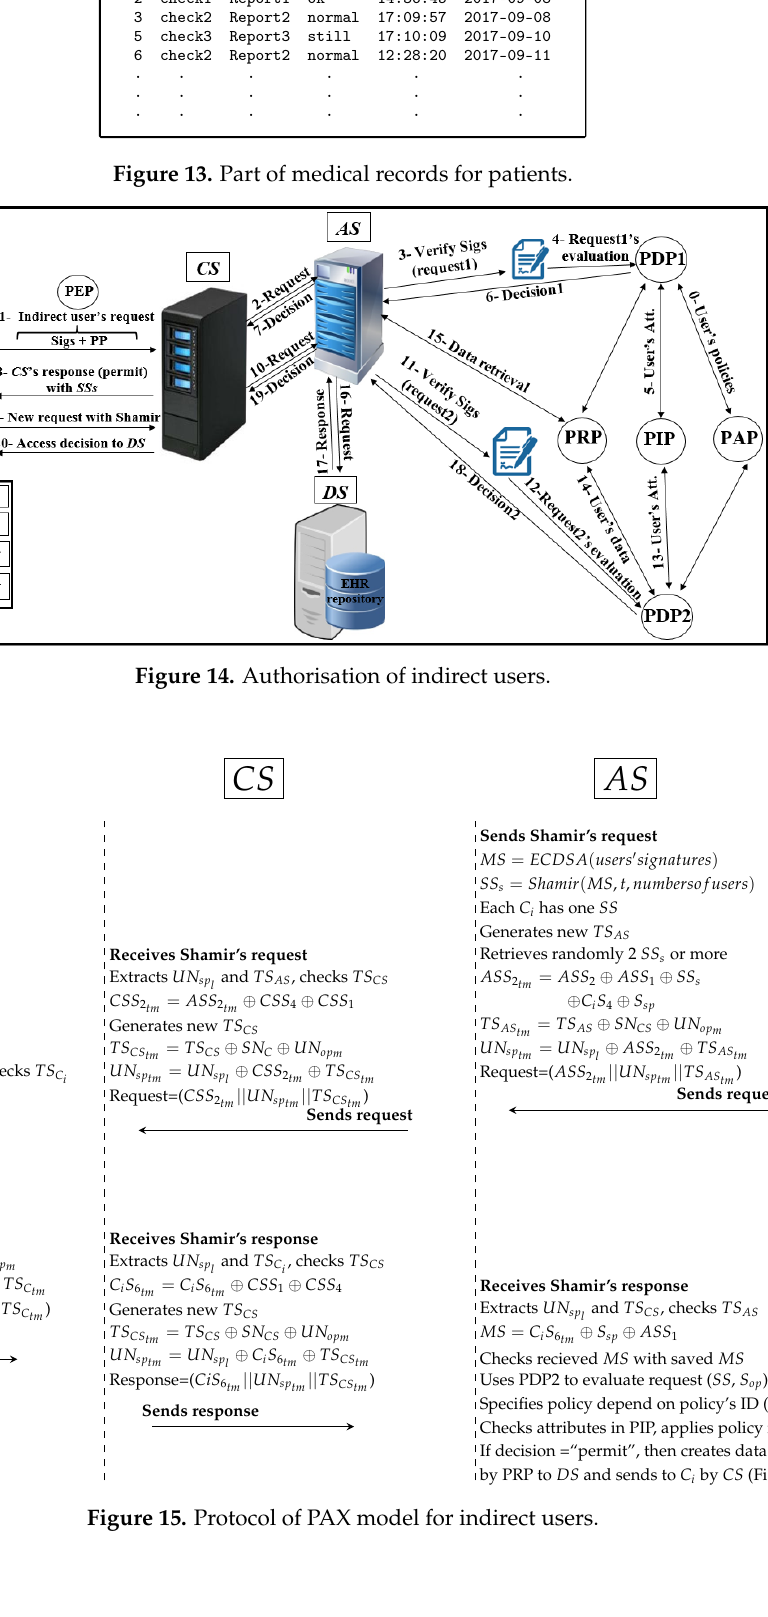
Figure 16. Part of Sarah’s data. Figure 17. Part of medical records